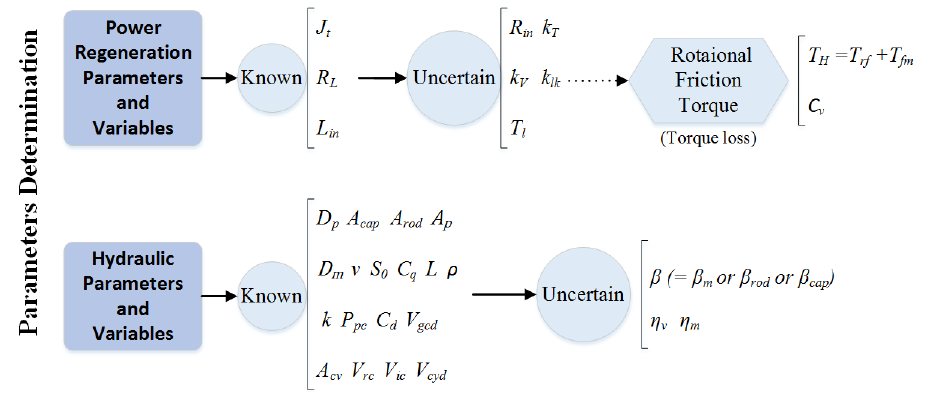
Figure 4. Known and uncertain parameters and variables in power regeneration unit and hydraulic